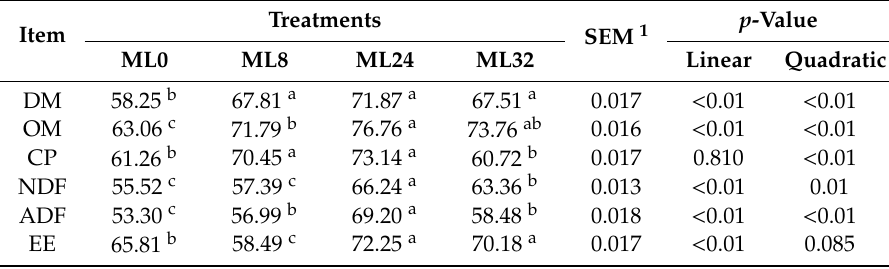
Table 3. E ff ects of inclusive ML treatments on the apparent digestibility of dietary nutrients in sheep.